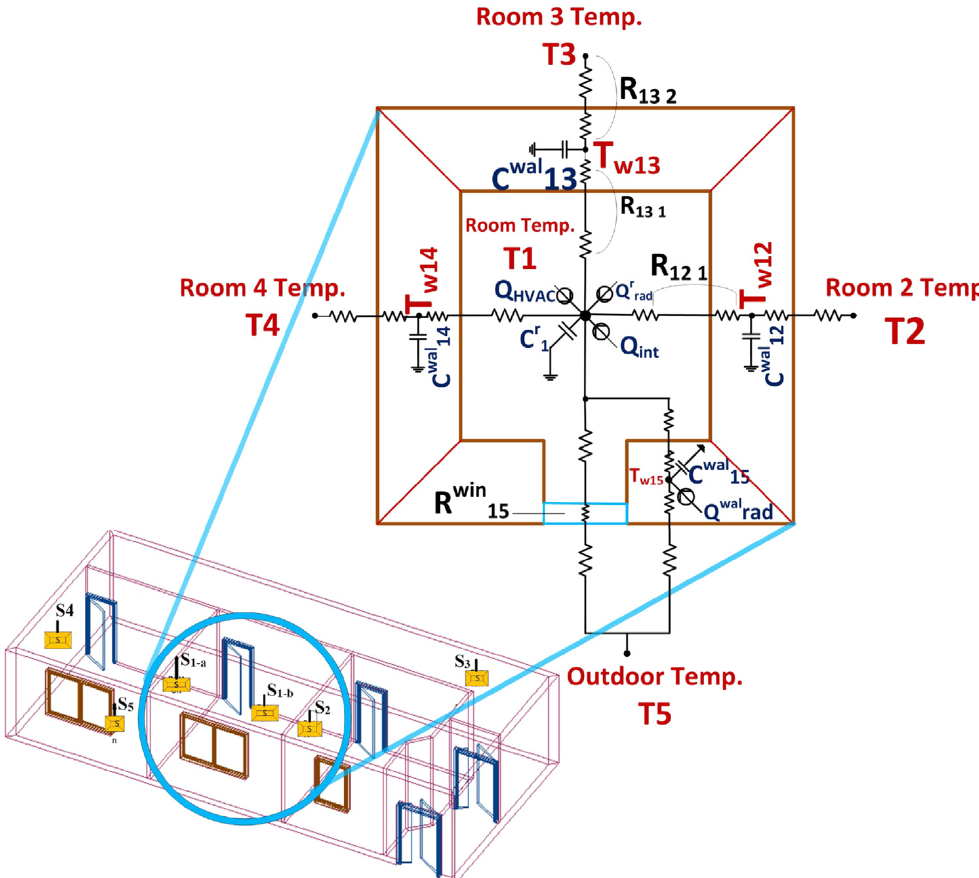
Figure 11. Schematic of a sample building room using the thermal/electrical analogy. (Adapted from [11] with permission of